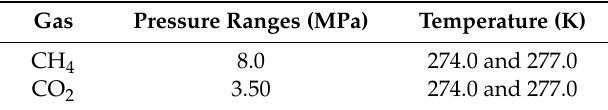
Figure 2. Pressure and Temperature—time plot recorded during hydrate formation testing. Table 2. The details of hydrate testing experimental conditions.